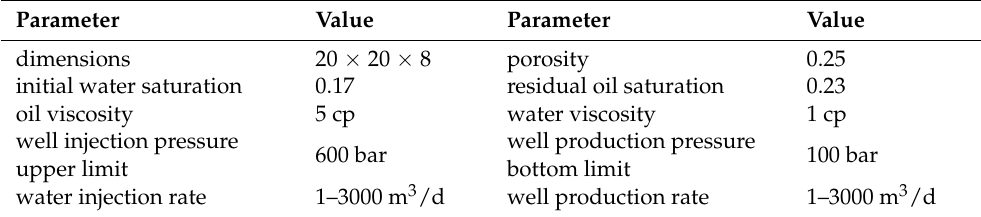
Table 1. Geostatistical parameters used to generate the geological models.